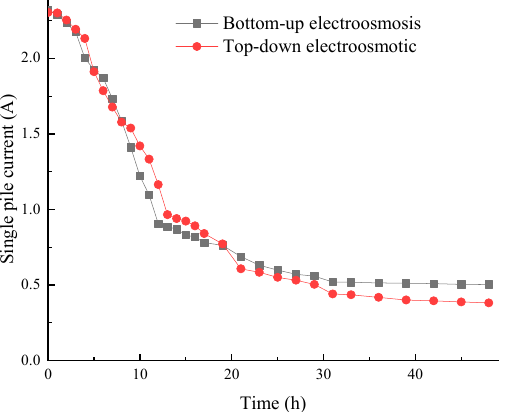
Figure 11. Variation curve of current with time during electro-osmosis test.